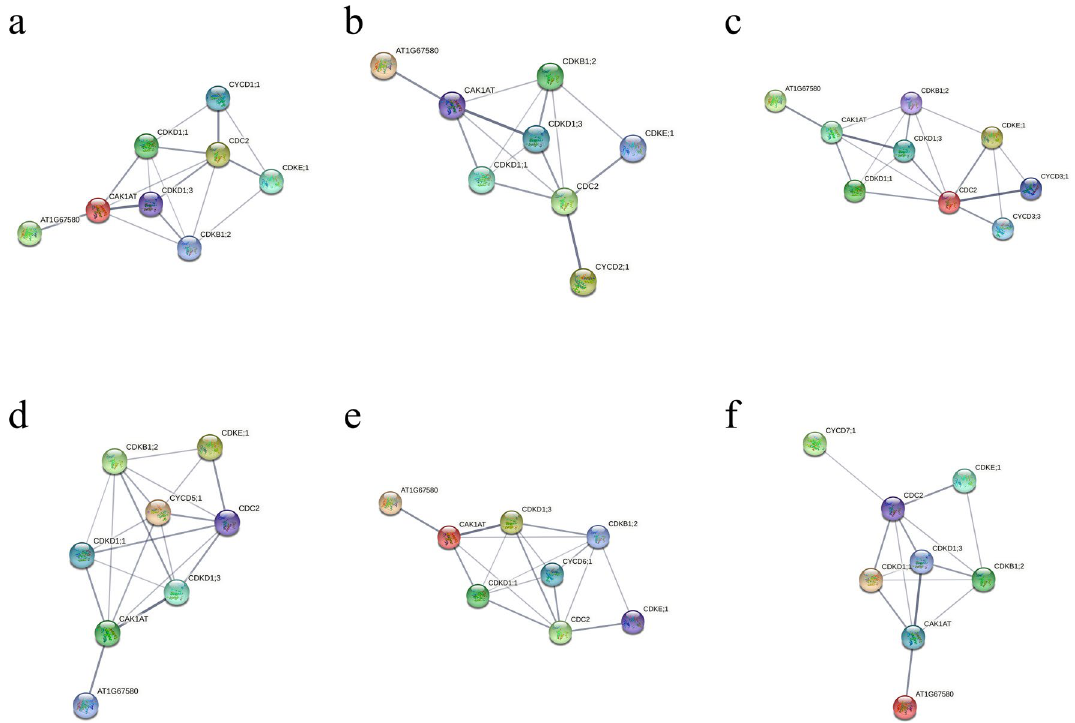
Figure 5. Prediction of the interaction between different subfamilies of PotomCYCDs and PotomCDKs gene family proteins by using the STRING website. ( a ) Interaction between D1 subfamily and CDKs. ( b ) Interaction between D2/4 subfamily and CDKs. ( c ) Interaction between D3 subfamily and CDKs. ( d ) Interaction between D5 subclass and CDKs. ( e ) Interaction between D6 subfamily and CDKs. ( f ) Interaction between D7 subfamily and CDKs. Line thickness indicates the strength of data